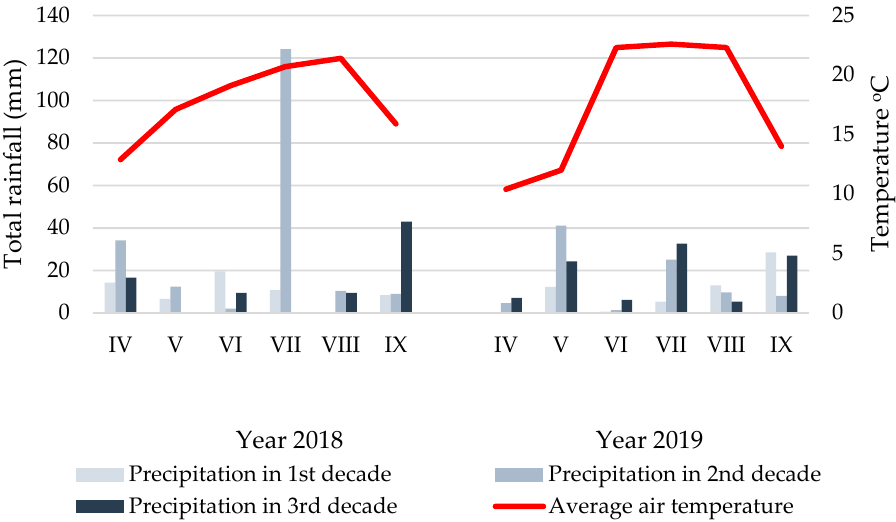
Figure 1. Distribution of precipitation during the growing season and average temperature of the month. IV—April; V—May; VI—June; VII—July; VIII—August;